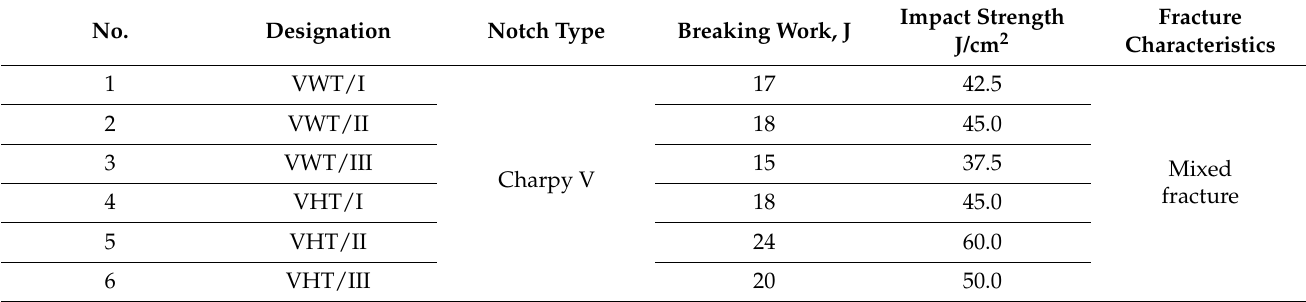
Table 8. Results of impact testing at − 40 ◦ C.